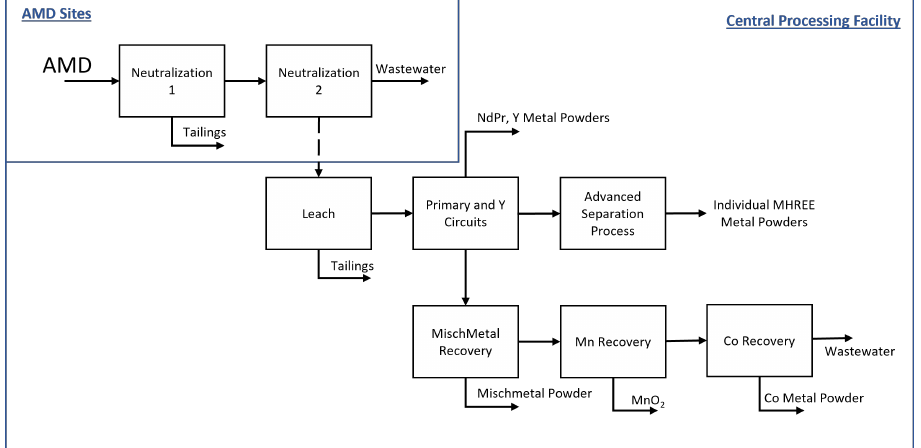
Figure 2. Proposed block flow